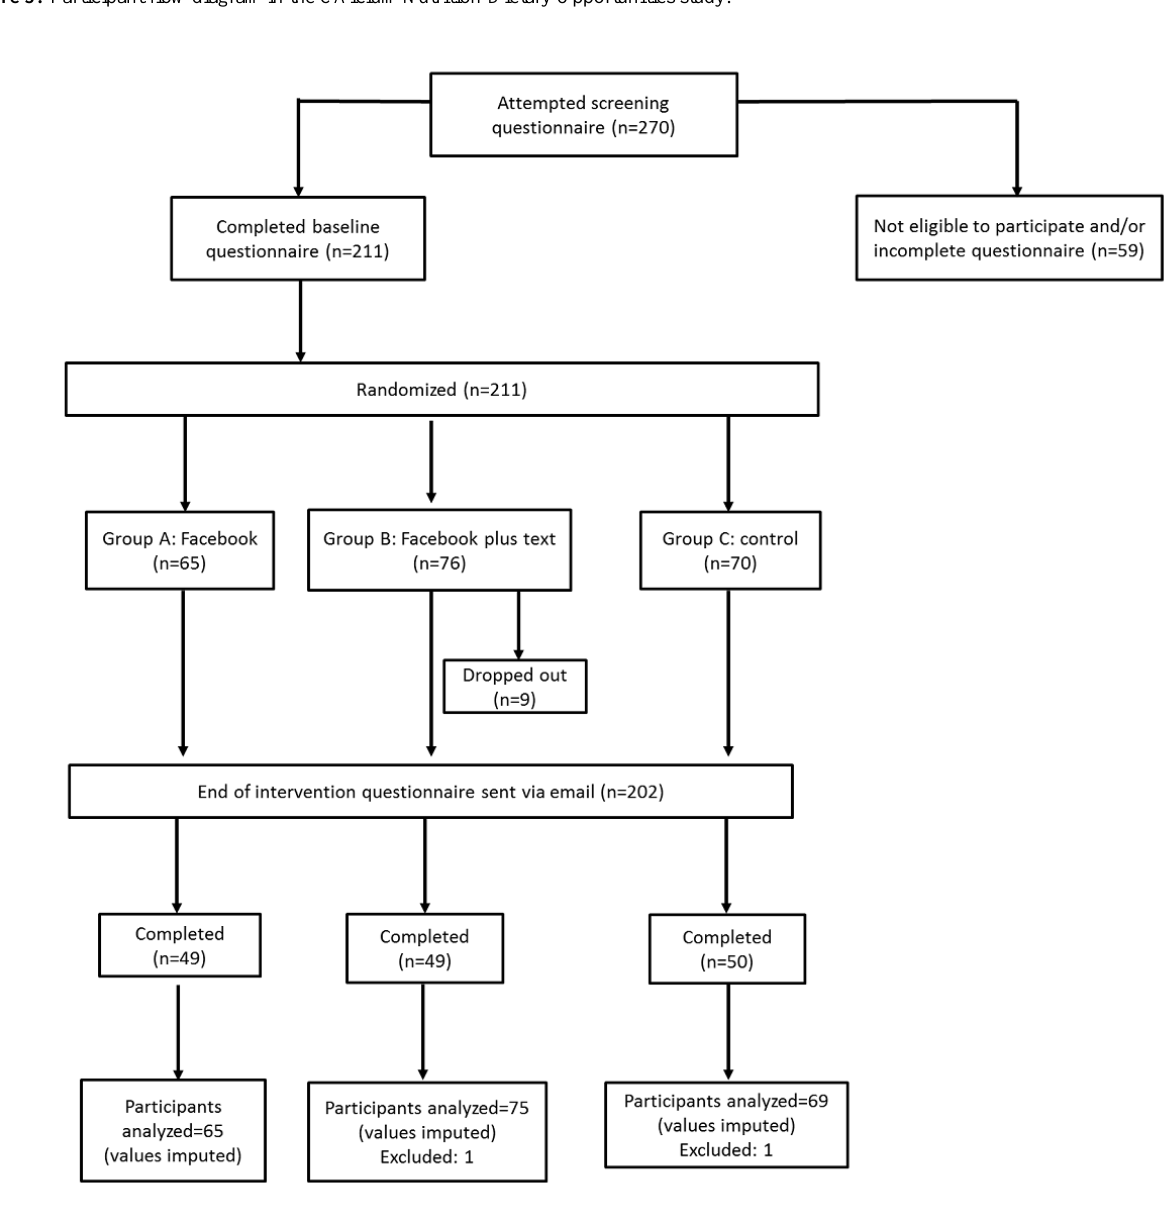
Figure 3. Participant flow diagram in the CAlcium Nutrition-Dietary Opportunities